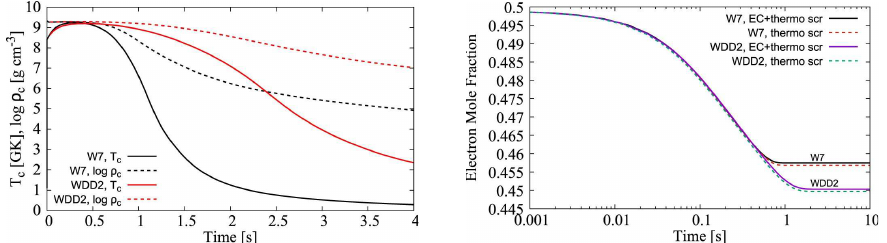
Figure 3. (Left) Time evolution of the central density ρ c and temperature T c . The solid lines show T c and the broken lines show ρ c . The upper (lower) lines are obtained by the WDD2 (W7) model of SNe Ia. (Right) Time evolution of the electron fraction Y e at the center of the SN Ia models. The solid lines show the result with the SCR e ff ects on both e-capture and thermonuclear reactions, while the broken lines show the result with the SCR e ff ect only on thermonuclear reactions. Taken from